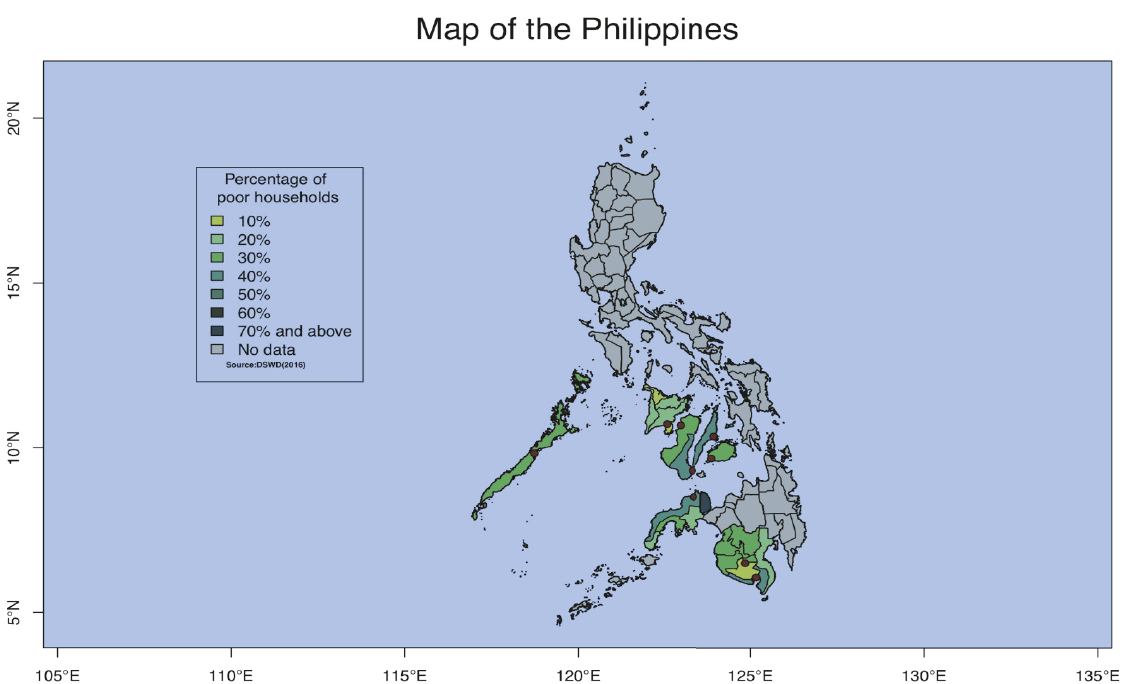
Figure 2: Green areas are shaded according to the percentage of poor households in provinces where ICM works in. Red dots indicate locations of ICM’s offices.